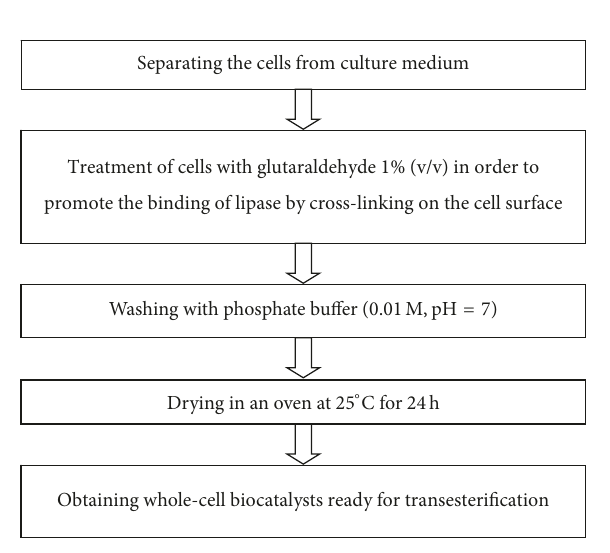
Figure 3: Whole-cell biocatalysts